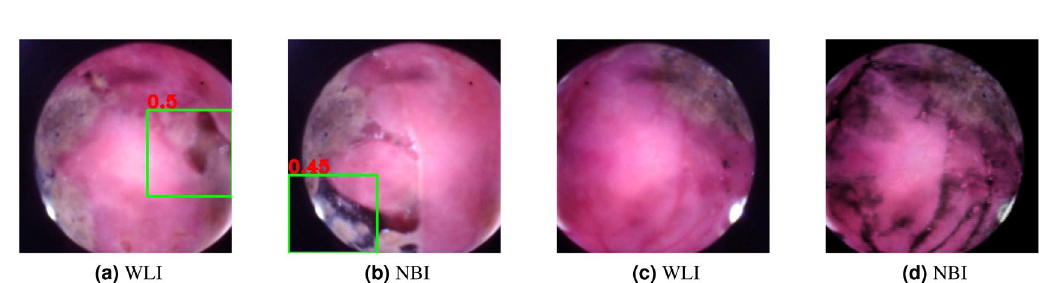
Figure 6. White light (WLI) and narrow band imaging (NBI)